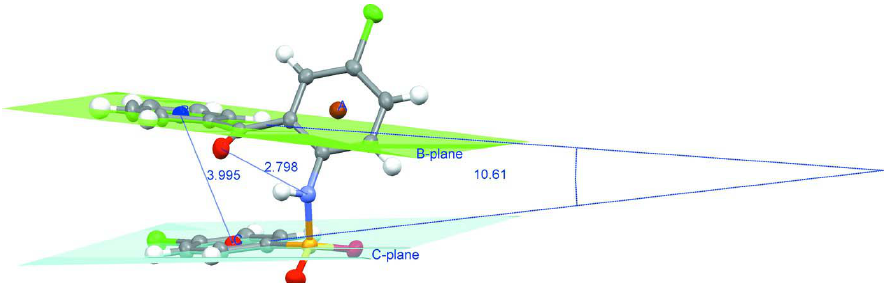
Figure 2 Molecular conformation with selected geometric